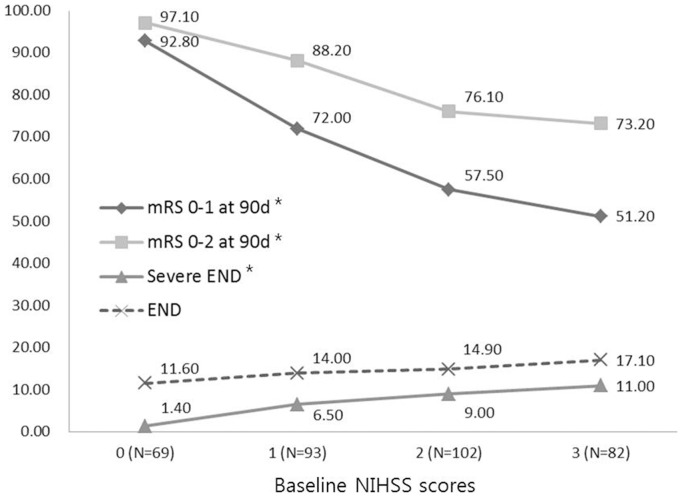
The distribution of various types of END and mRS scores of 0–1 and 0–2 at 90 days in terms of baseline NIHSS scores (*
p for trends <0.05).